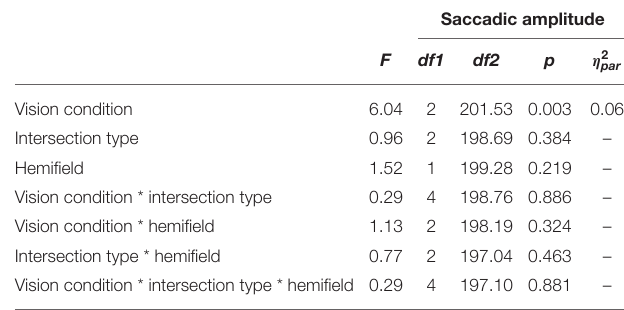
TABLE 5 | Results of the mixed-model ANOVA for number of fixations (Bonferroni corrected for additional analysis on fixation duration, see Table 6 ).